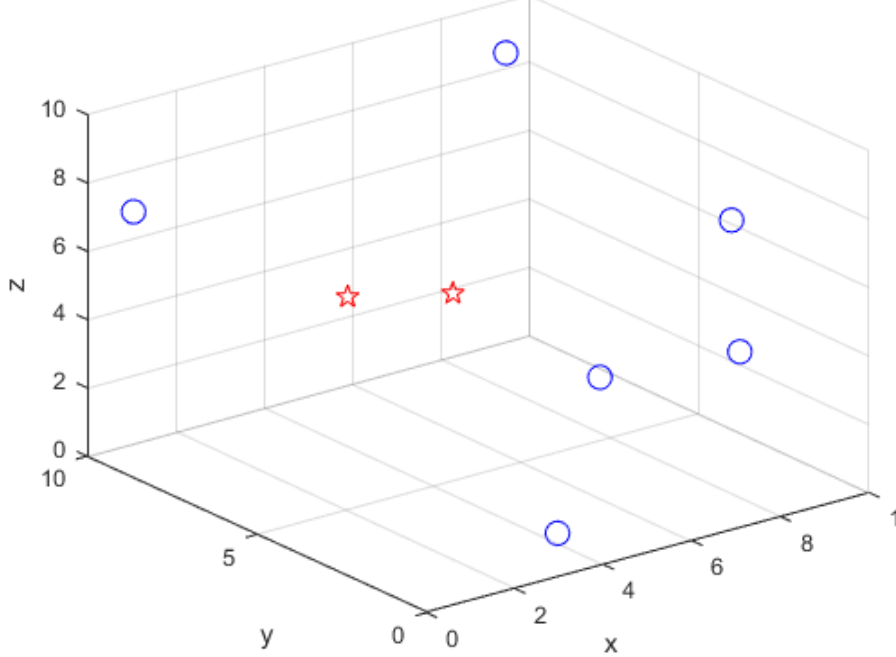
Figure 3. A 3-D deployment example of targets and anchor nodes under N = 6 and M = 2 where the target and anchor node are represented as the star and circle marks,